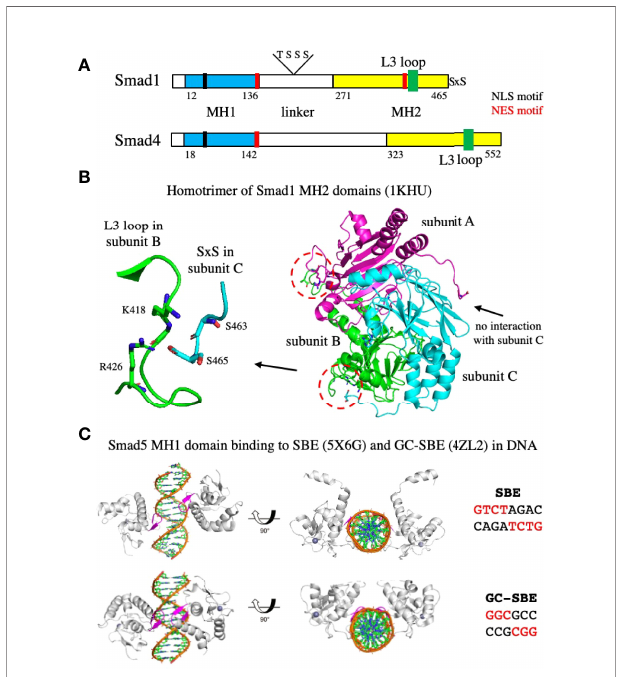
FIGURE 6 | Organization of Smads, homotrimerization of the MH2 domain, and binding of the MH1 domain to DNA. (A) A schematic diagram showing the organization of Smad1 and Smad4. Both Smads contain an MH1 domain, a central proline-rich linker, and a carboxy-terminal MH2 domain. Smad1 contains two serine residues at the C-terminus that are phosphorylated by the type I receptor kinase. NLS and NES motifs important in the export into and out of the nucleus, and threonine and serine residues phosphorylated by CDK8/9 (S206 and S214) or GSK-3 (T202 and S210) in the linker of Smad1 are shown. The numbering corresponds to amino acid residues in UniProtKB accession numbers Q15797 (human Smad1) and Q13485 (human Smad4). (B) Structure of the Smad1 MH2 domain homotrimer. The C-termini of subunits B and C interact with the L3 loops in subunits A and B, respectively, indicated by the red dashed circles. An enlargement of the interaction between the serine residues at the C-termini of subunit C with residues in the L3 loop of subunit B is shown on the left. The C-termini of subunit A does not interact with the L3 loop of subunit C. (C) Structures of the Smad5 MH1 domain bound to the SBE or GC-SBE elements in DNA. The b -hairpin responsible for DNA sequence recognition (shown in magenta) is embedded in the major groove of DNA. PDB fi les used to generate the structures are